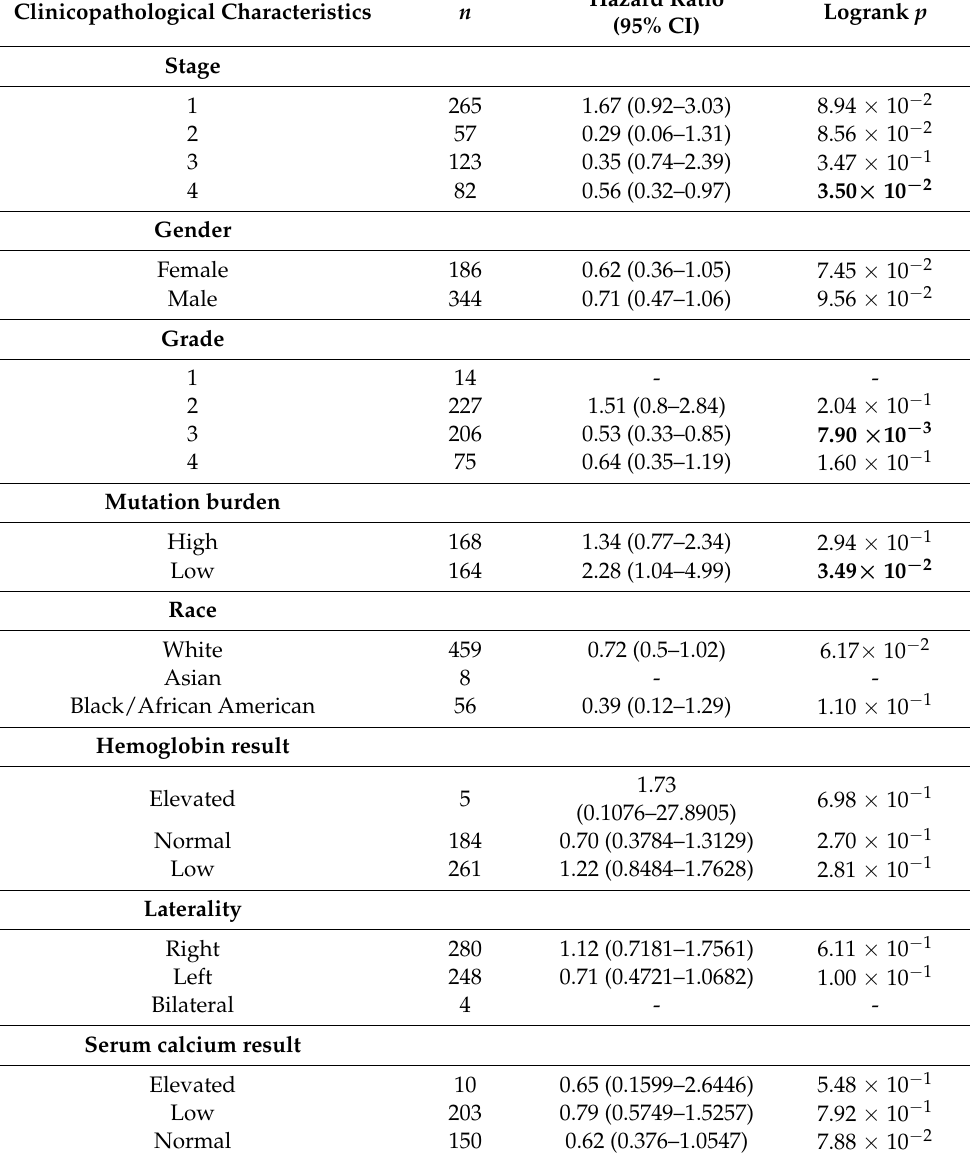
Table 1. Correlation of GOT2 mRNA expression and clinical outcomes in KIRC from TCGA